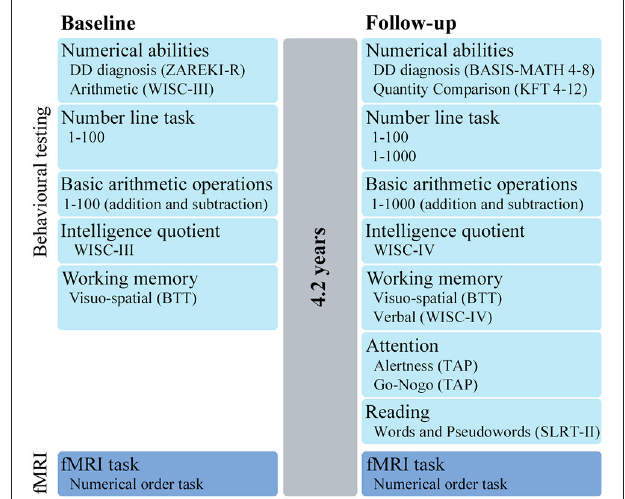
FIGURE 1 | Study design. Overview of the behavioral tests and fMRI task performed at baseline and after 4.2 years at follow-up. ZAREKI-R, Neuropsychological Test Battery for Number Processing and Calculation in Children; BASIS-MATH 4–8, Basic Diagnostic in Mathematics for Grades 4–8; KFT 4–12, Cognitive Abilities Test; WISC, Wechsler Intelligence Scale for Children; BTT, Block-Tapping-Test; TAP, Testbattery for Attentional Performance; SLRT-II, Salzburg Reading and Orthography